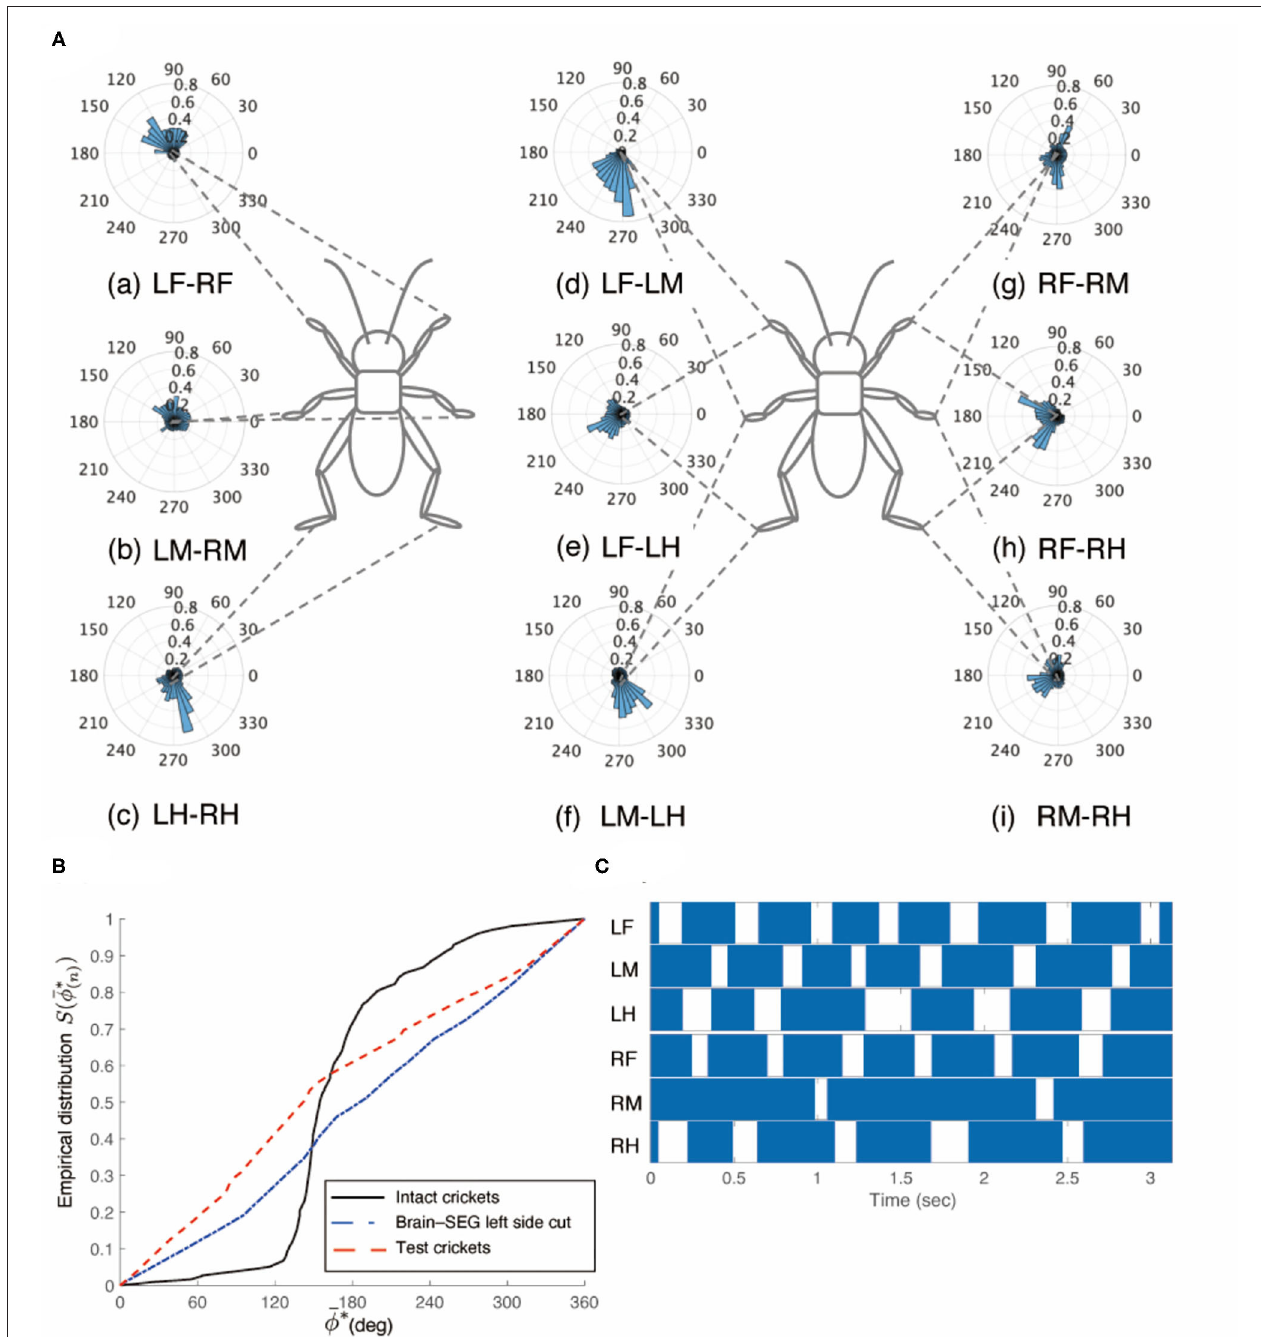
FIGURE 7 | Walking gait patterns of crickets in which left side of nerve connectives between brain and SEG, and right side of connective between SEG and prothoracic ganglion were cut. (A) Polar histograms indicate phase differences between two legs in test crickets ( N = 5). The test crickets continued to turn clockwise. The polar histograms demonstrate that the walking pattern was not a tripod gait. (a–i) Phase differences between pairs of legs. (B) Comparison of the empirical distribution function of phase differences between left and right legs Φ LM − RM The black line indicates the empirical distribution function of the intact crickets; the blue line indicates that of the test crickets, and the red line indicates that of the crickets in which the left side of the nerve connectives between the brain and SEG was cut (shown in Figure 3B ). (C) Gait chart diagram of test cricket. The filled parts indicate the duration of the power stroke period, and the blank part indicates the duration of the recovery stroke. This demonstrates that the walking pattern was not a tripod gait in the test crickets. LF, left foreleg; RF, right foreleg; LM, left midleg; RM, right midleg; LH, left hind leg; RH, right hind leg.